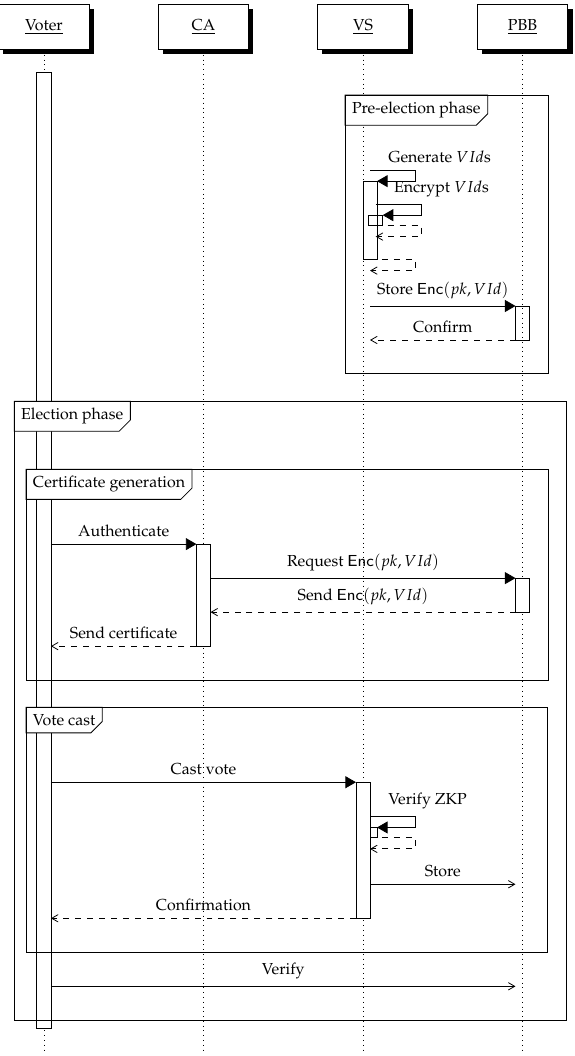
Figure 1. Diagram presenting a summary of the pre-election and election phases involving the voters, certificate authority, voting server and public bulletin